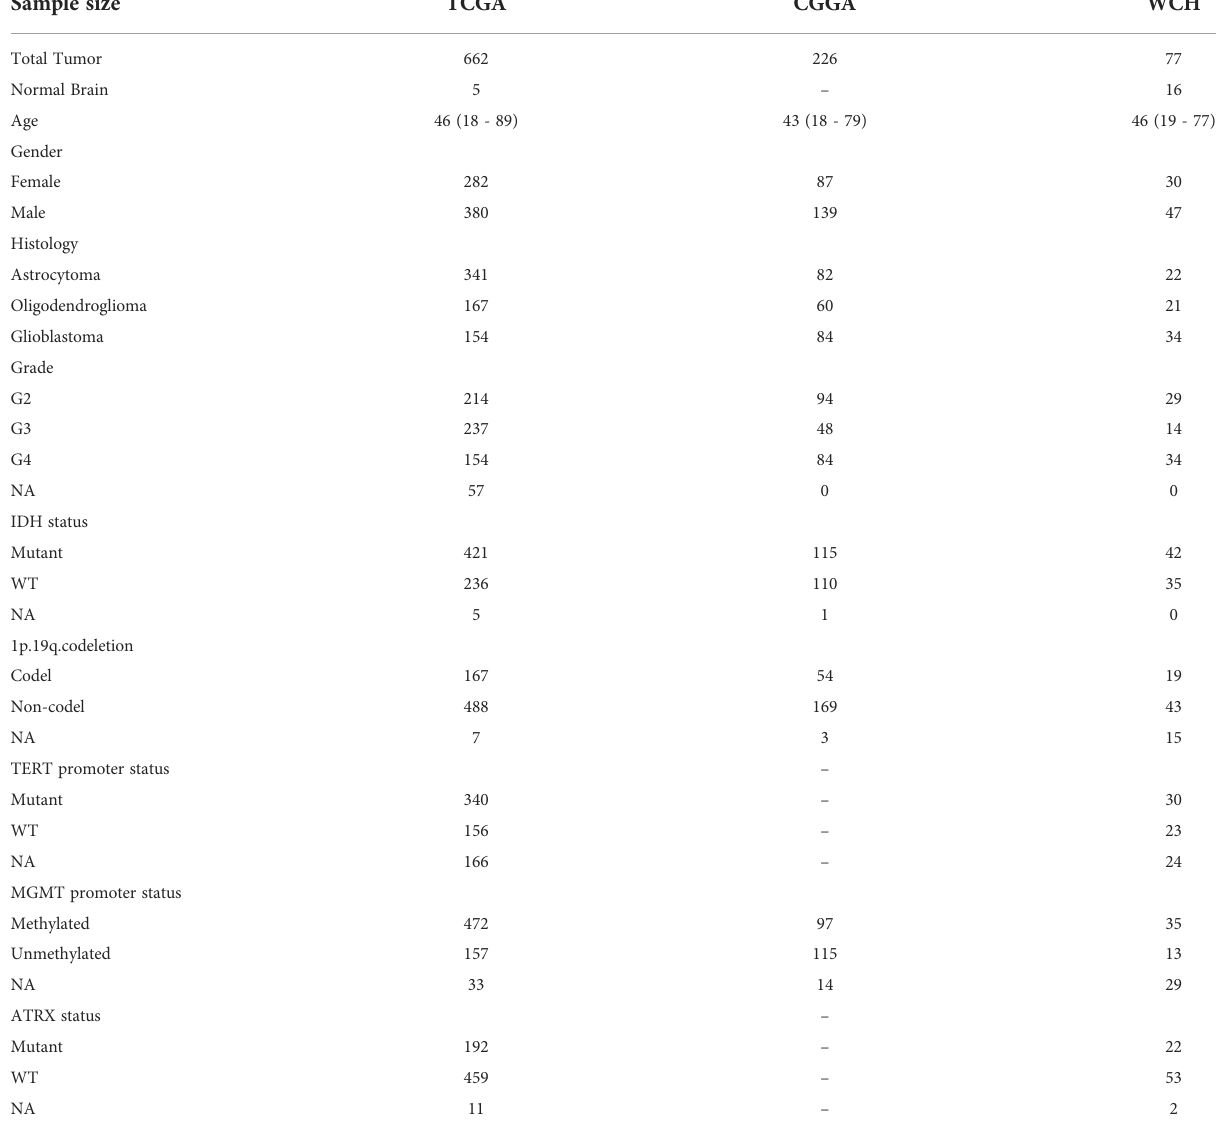
TABLE 1 Clinicopathological characteristics of adult primary glioma patients in TCGA, CCGA, and WCH cohort. Sample